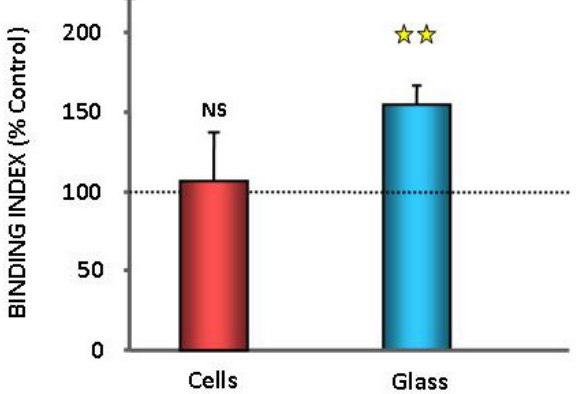
Figure 2. Effect of GABA (10 − 5 M) on the adhesion properties of P. fluorescens MF37 to eukaryotic cells or glass. Adhesion is expressed as the percentage of the control value (dotted line) (NS: non-significant;  : p < 0.01).